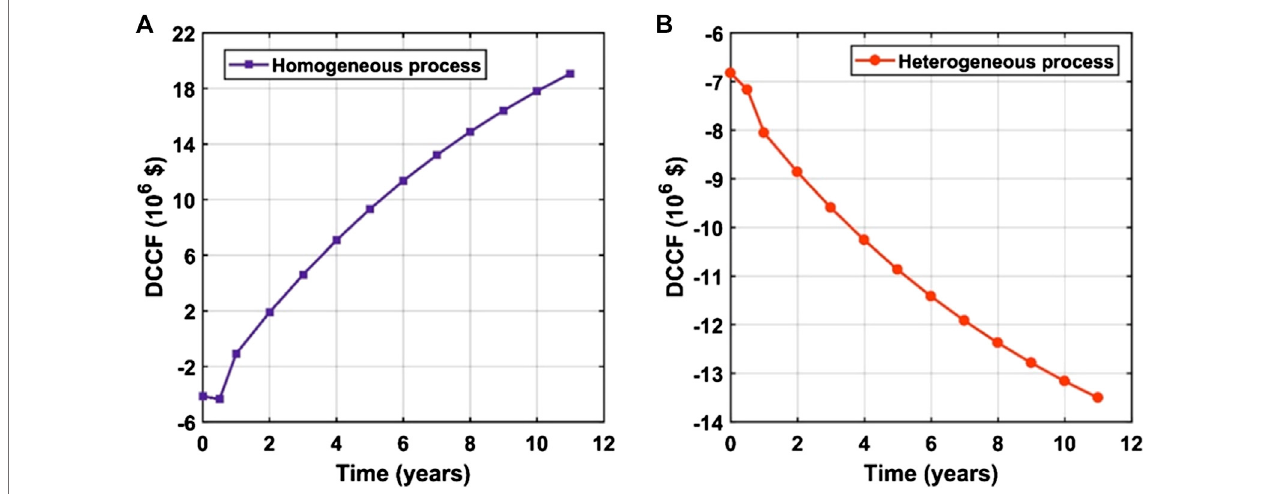
FIGURE 5 | Discount cumulative cash fl ow as a function of the operating time (years) for the (A) homogeneous process and (B) heterogeneous process.